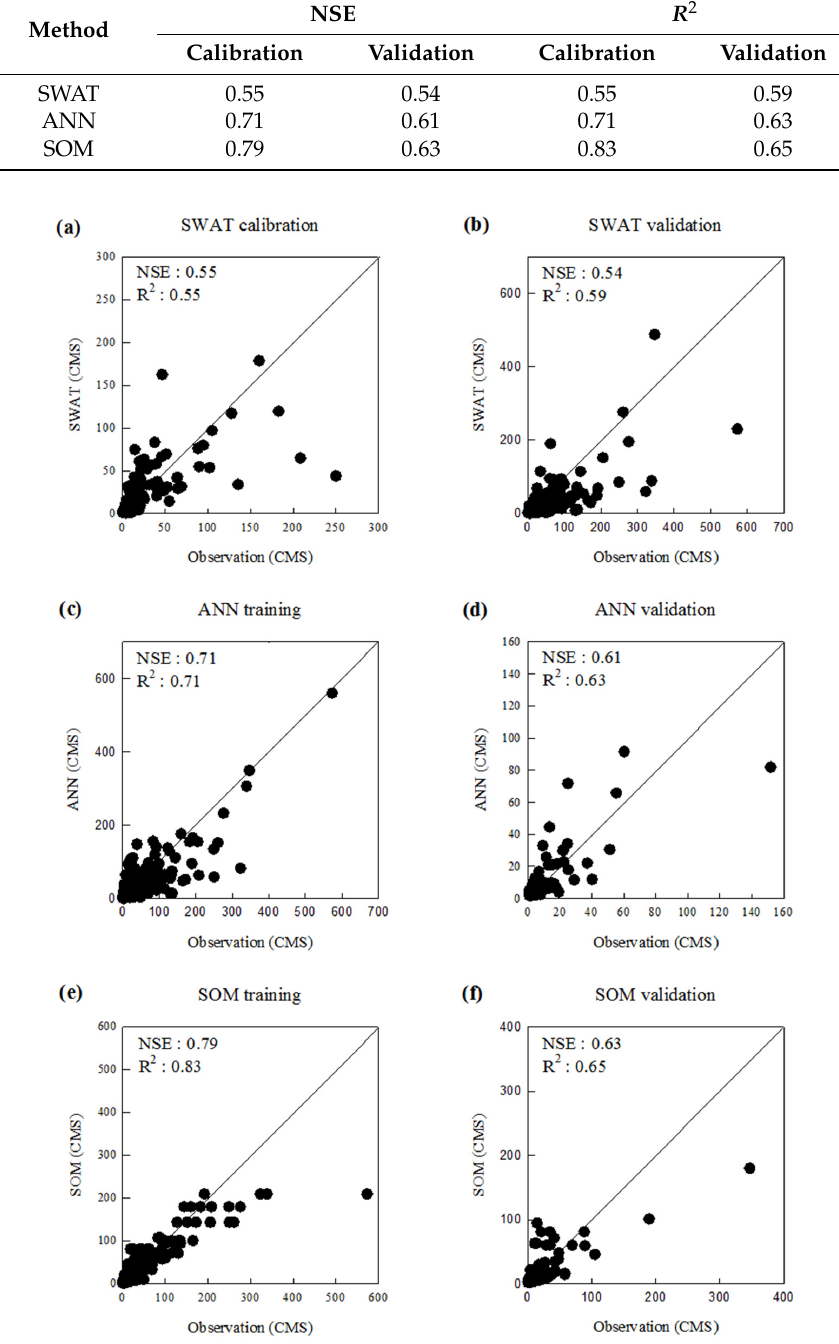
Figure 3. Calibration, training, and validation results of three models: ( a ) SWAT calibration; ( b ) SWAT validation; ( c ) ANN training; ( d ) ANN validation; ( e ) SOM training; and ( f ) SOM validation.